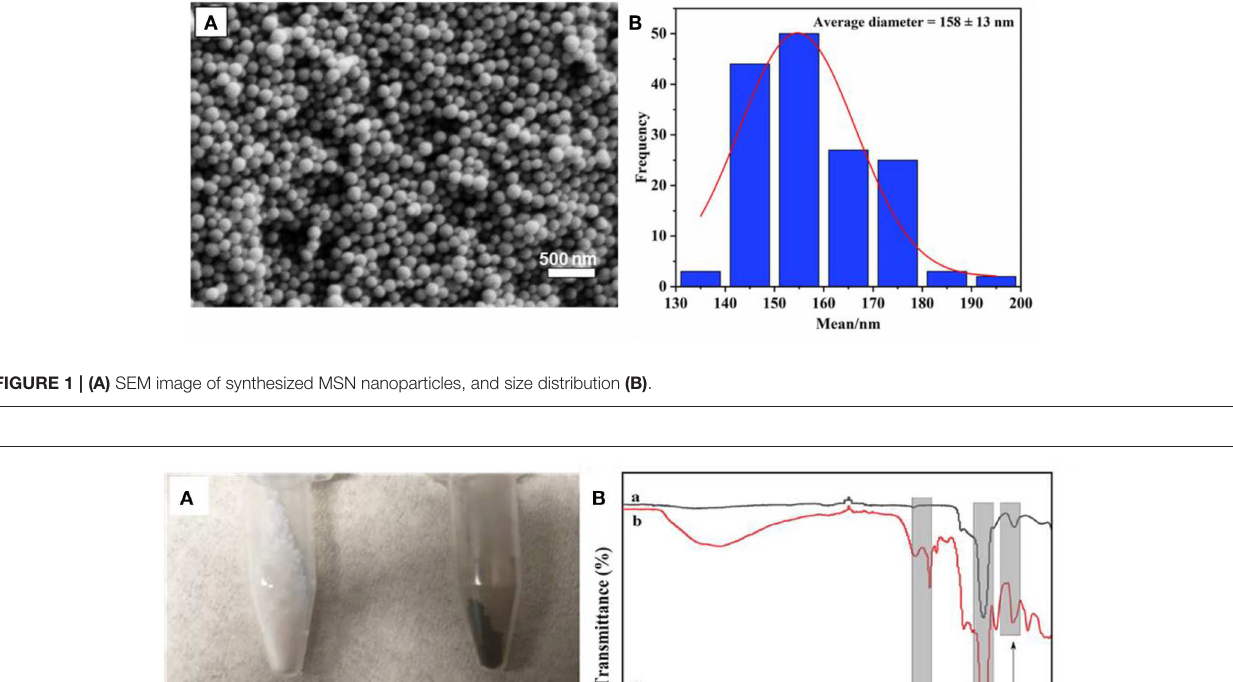
Frontiers in Chemistry |